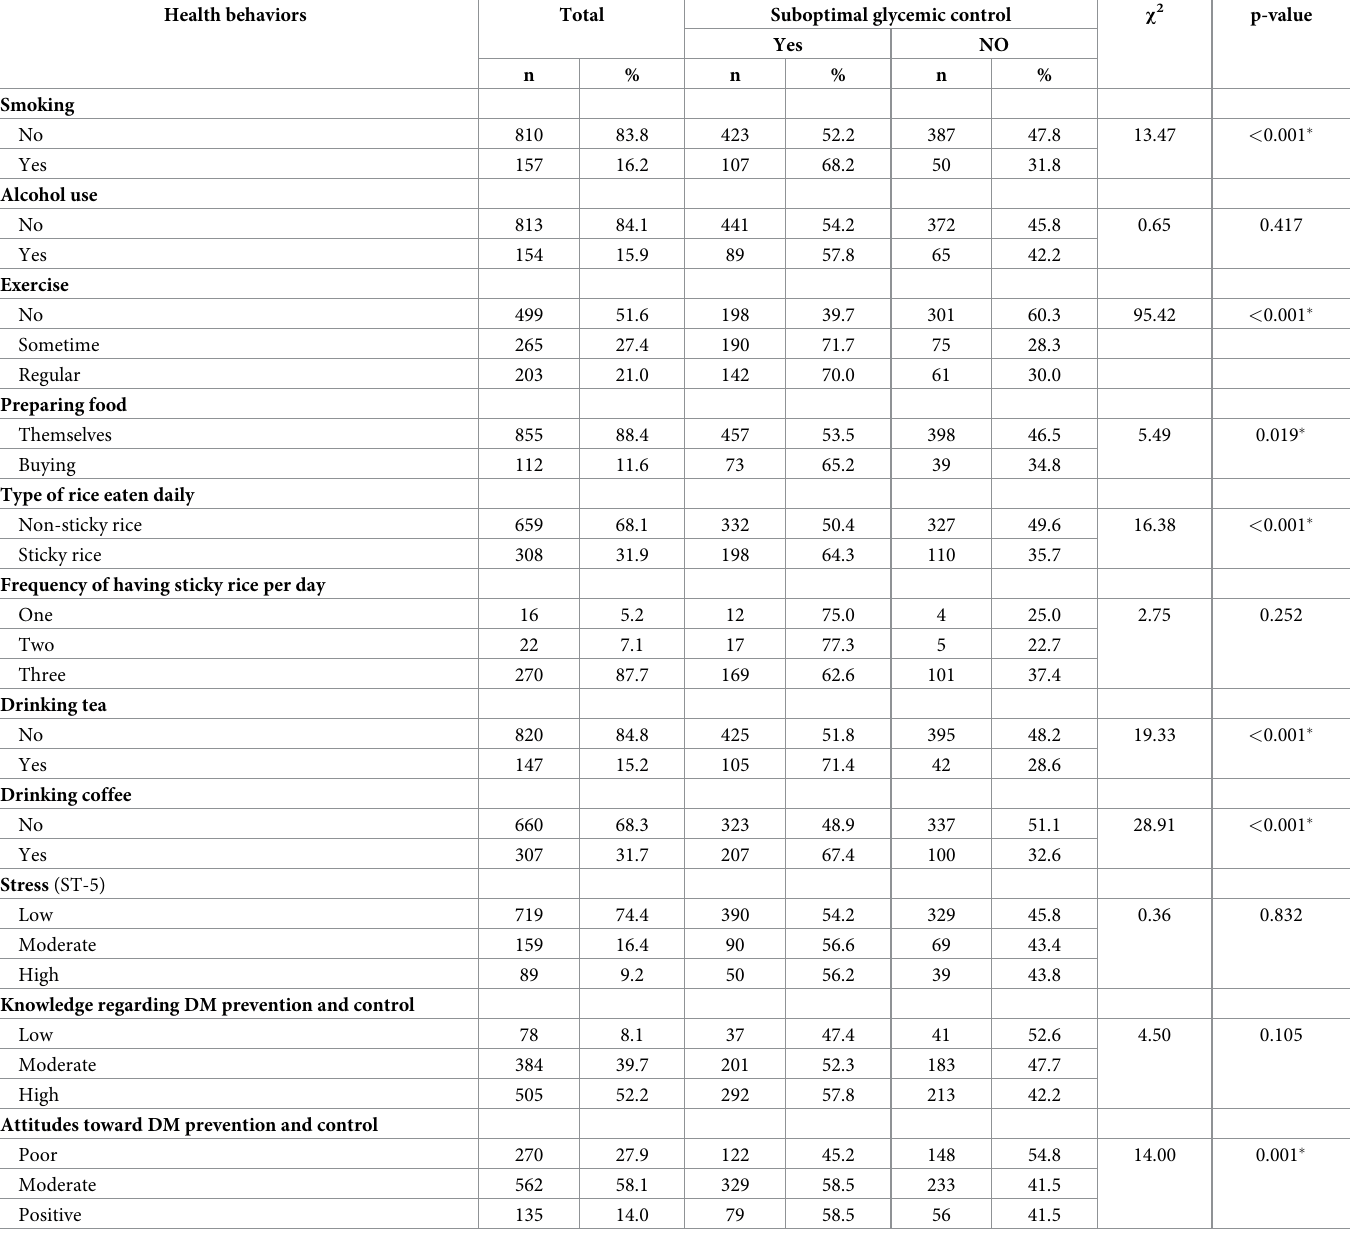
Table 2. Substance use and health behaviors among the participants. Health